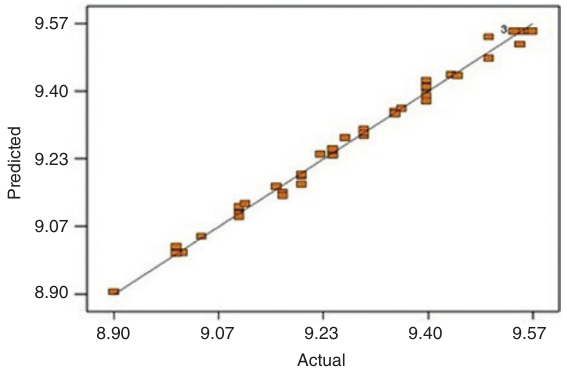
Figure 5: Correlation between the predicted and actual values.